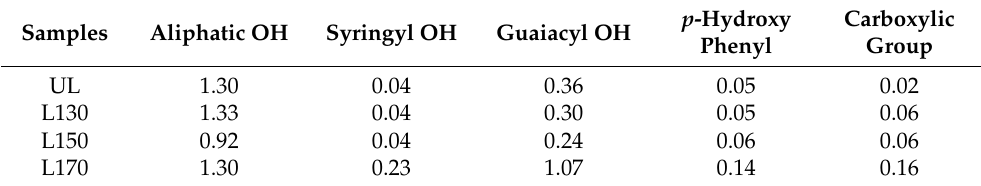
Table 4. Quantification of the UL, L130, L150, and L170 fractions by quantitative 31 P-NMR analy- sis